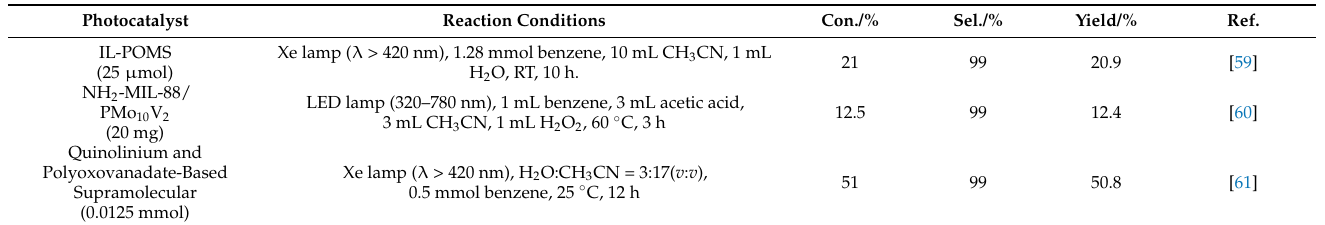
Table 2. Catalytic performance of POMs-based photocatalysts for benzene hydroxylation.